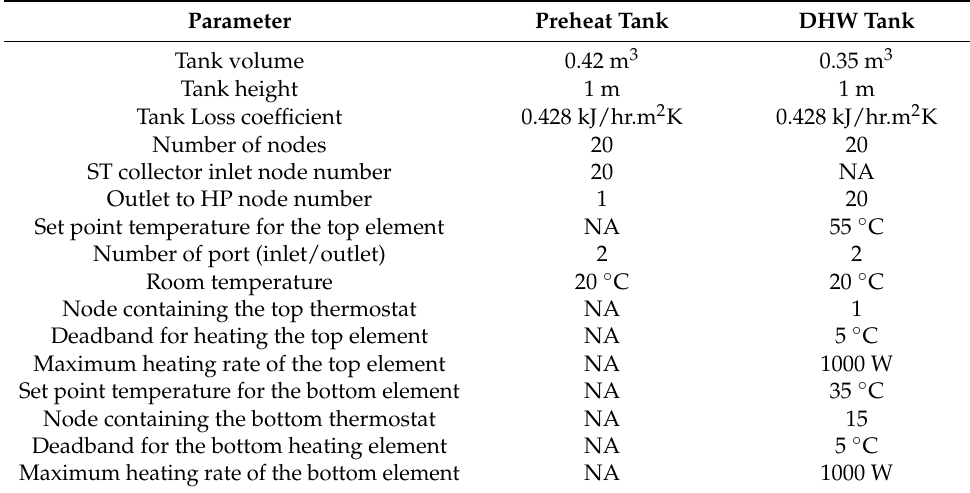
Table 2. Preheat and DHW tank